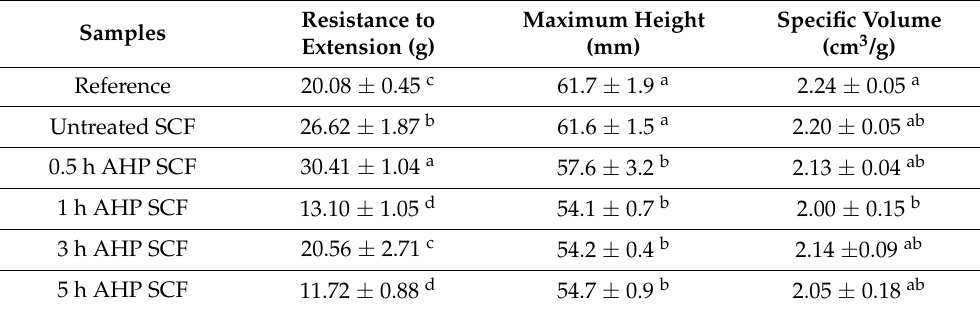
Table 3. Extensibility of dough samples, maximum height, and specific volume of bread samples without SCF incorporated (reference), incorporated with 5% untreated SCF, and 0.5 to 5 h AHP SCF. Resistance to Maximum Height Specific Volume Samples Extension (g) (mm) (cm 3 /g) Reference 20.08 ± 0.45 c Untreated